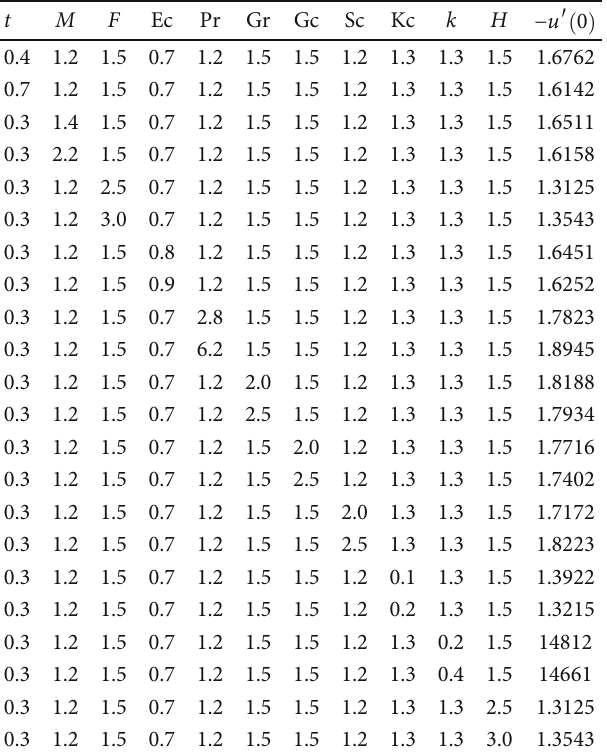
Table 6: Comparison of results of concentration, Kc = 0 : 5 , Ec = 0 : 3 , t = 1 , and y = 2 .